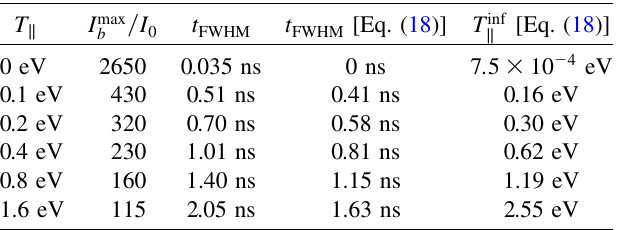
TABLE I. Compression dependence on initial T k for E (cid:4) 300 ns , and f (cid:4) 0 : 5 using the smooth waveform 400 keV , t p across the 3 cm long gap.